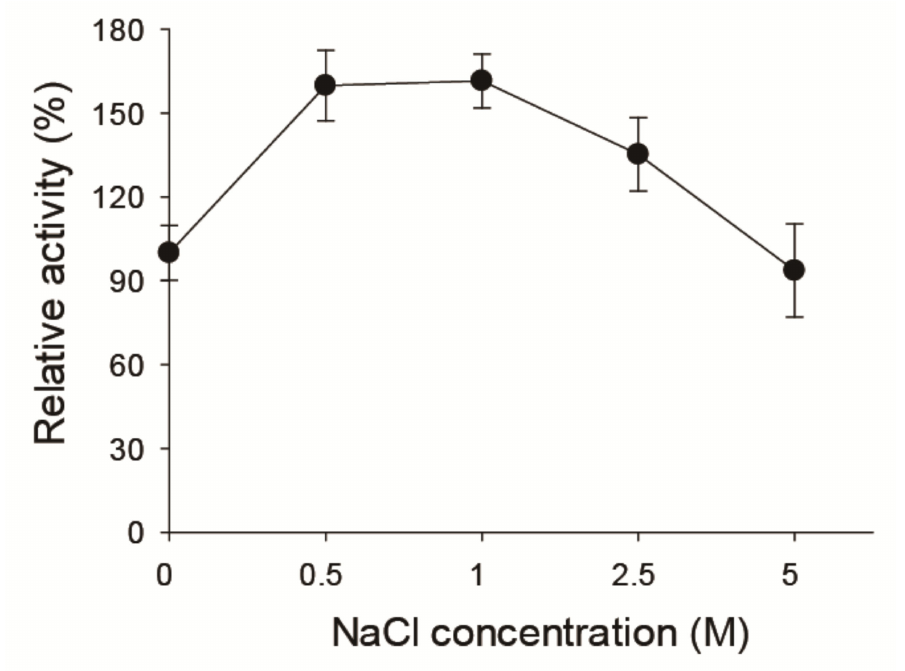
Figure 3. Effect of NaCl concentration on the L -fuculose-isomerizing activity of Ho FucI. The en- zyme reactions were performed with 7 µ g of Ho FucI and 10 mM L -fuculose at 60 ◦ C for 5 min in 20 mM sodium phosphate (pH 7.0) buffer in the presence of 1 mM Mn 2+ . The reaction solution contained various NaCl concentrations ranging from 0 to 5 M. The experimental data represent the means ± standard deviations of three replicates. Relative activity (%) represents the enzyme activity relative to that obtained without supplementation of NaCl, set as